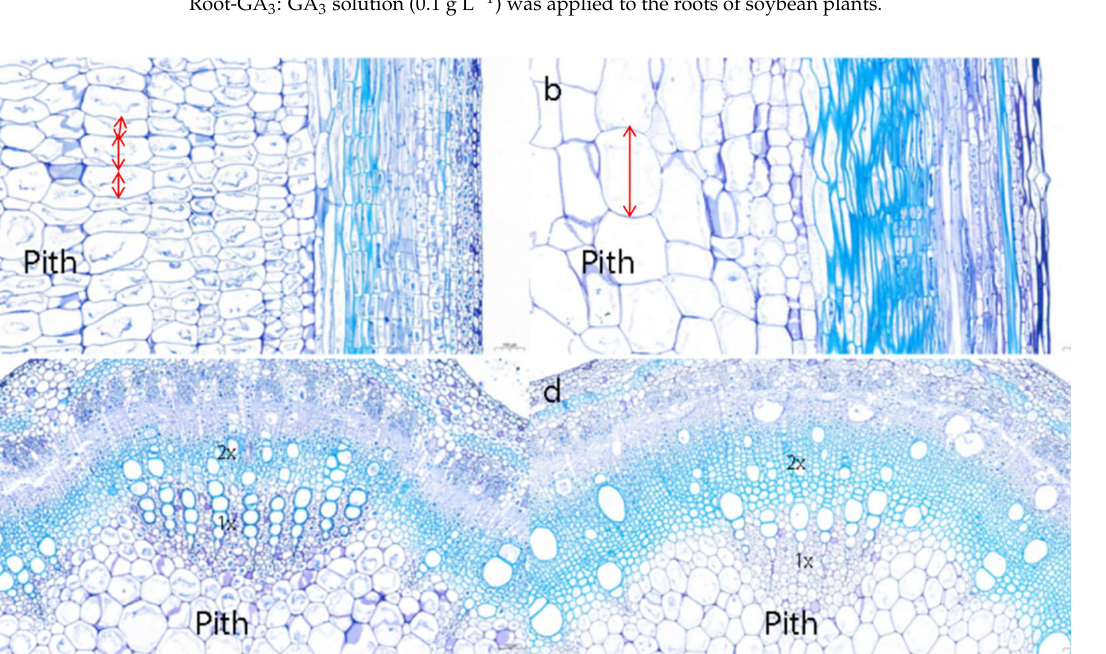
Figure 1. Anatomical structure of soybean internodes (100 × ). ( a , b ) Longitudinal section images of the 2nd internode of CK and V1-GA 3 -treated plants. ( c , d ) Cross-sectional images of the 2nd internode of CK and V1-GA 3 -treated plants. 1 × , primary xylem; 2 × , secondary xylem.